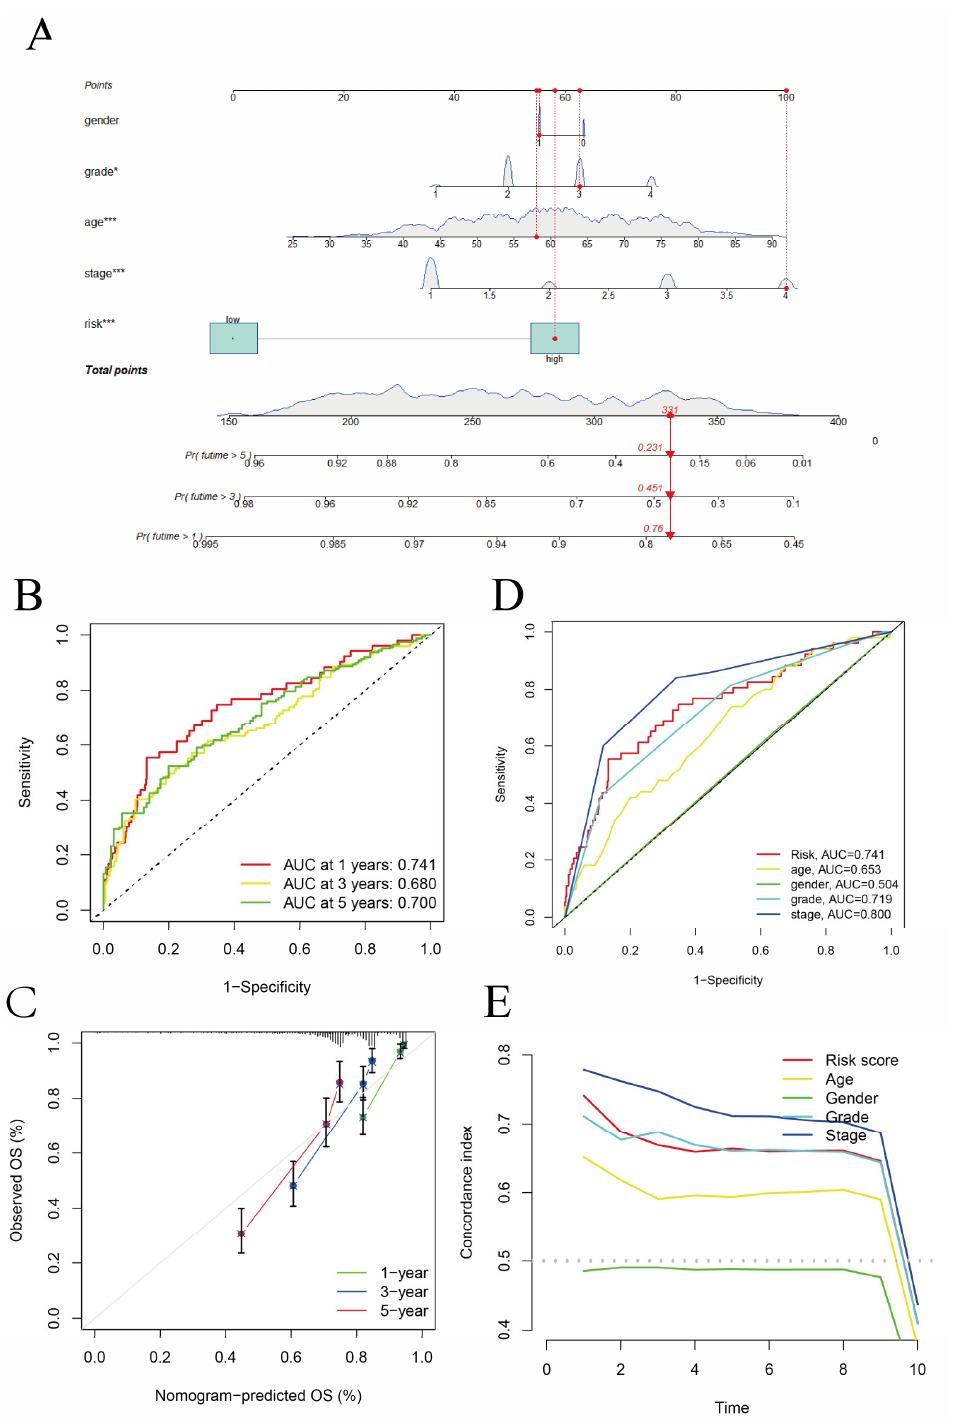
Figure 8. Nomogram, AUC, and DCA analysis. ( A ) Based on the selected CRLR prognostic signature and independent factors in ccRCC (* p < 0.05, *** p < 0.001). ( B ) The OS of AUC predictive for 1 year, 3 years, and 5 years. ( C ) Calibration plot of the CRLR nomogram. ( D ) The AUC of CRLRs and traditional clinical variables. ( E ) DCA plot of the CRLRs and traditional clinical variables.